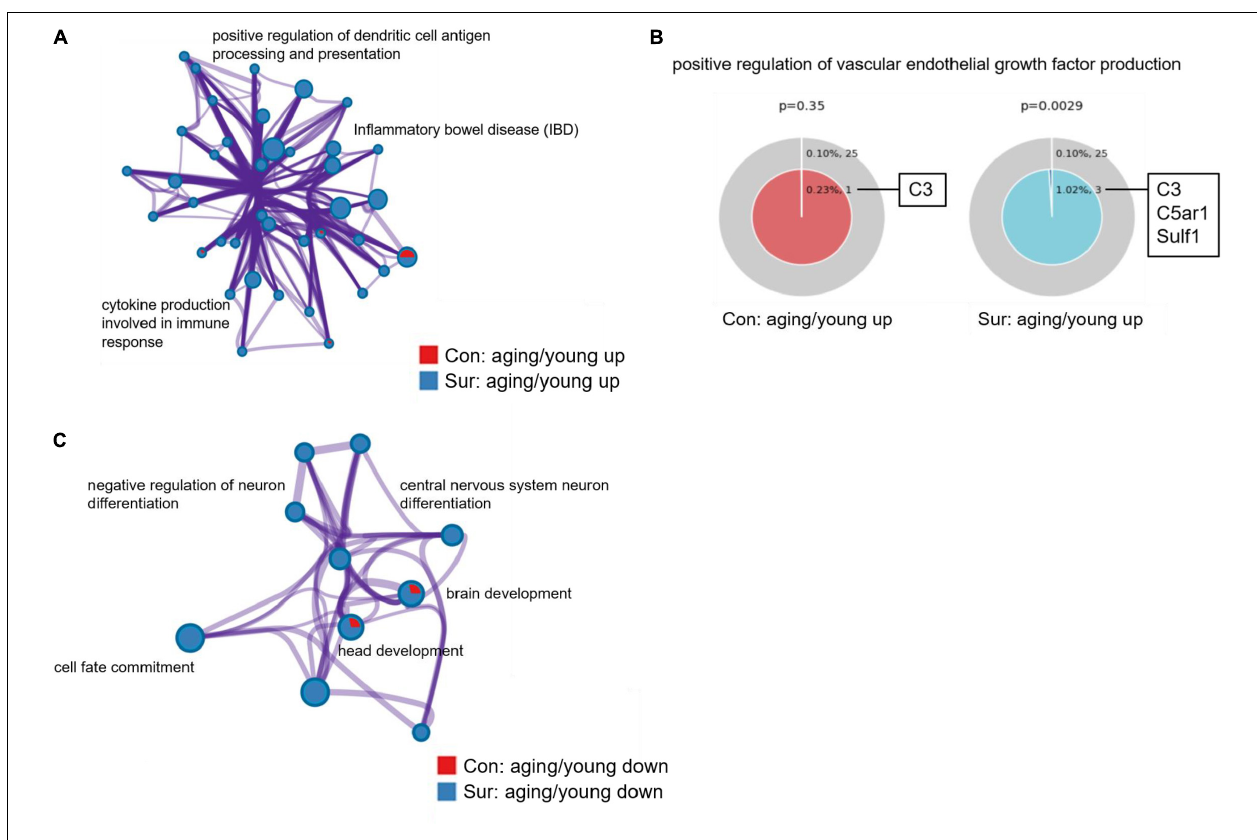
FIGURE 5 | Gene annotation and enrichment of dysregulated mRNAs. (A,B) The enrichment analysis of upregulated mRNAs between young and aging mice under control (red) and anesthesia/surgery (blue) conditions. (A) Enrichment network constructed by enriched terms. (B) Enriched GO term: “positive regulation of vascular endothelial growth factor production” (GO:0010575). The term related mRNAs are as shown in the figure. P < 0.05 is considered as statistically significant. (C) The enrichment analysis of downregulated mRNAs between young and aging mice under control (red) and anesthesia/surgery (blue) conditions. And enrichment network constructed by enriched